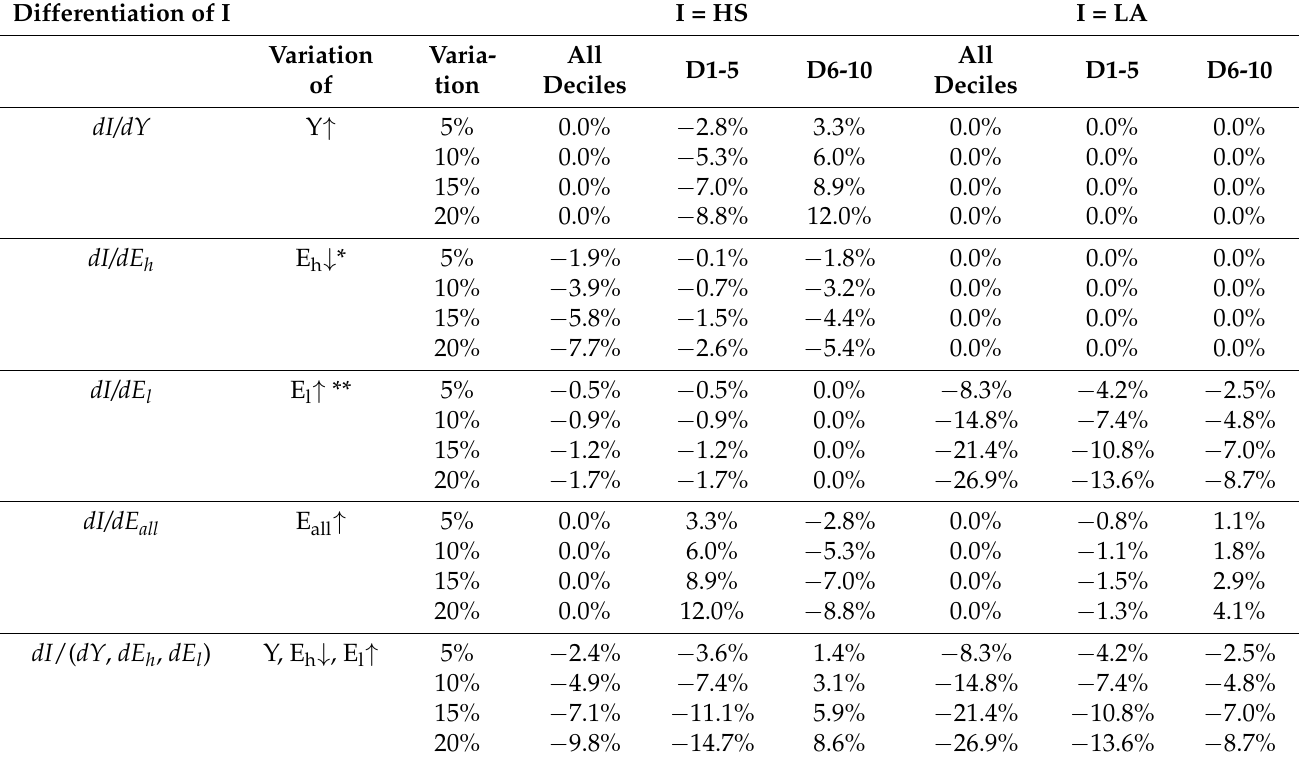
Table 5. Sensitivity results for HS and LA indicators, by scenario and variation in